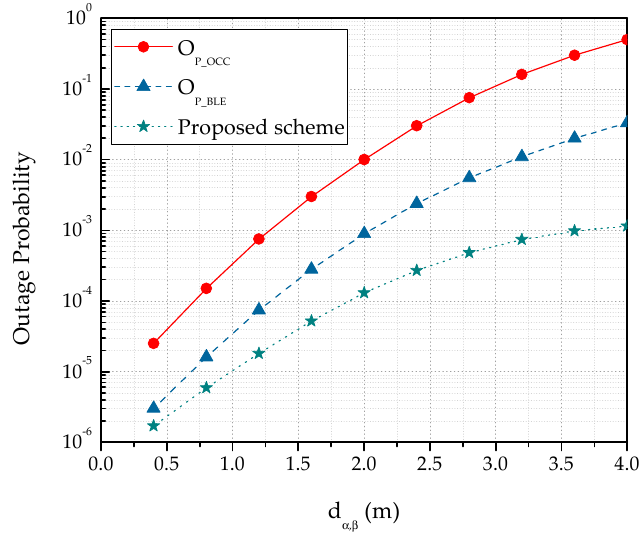
Figure 8. Comparison of the outage probabilities in the OCC, BLE, and proposed schemes.